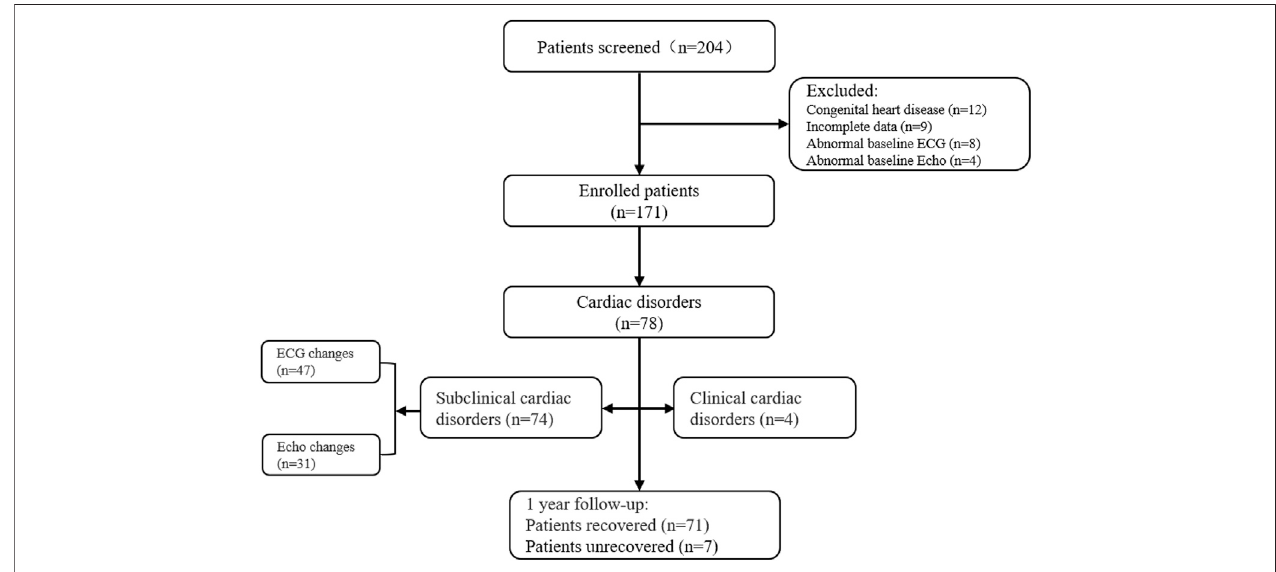
FIGURE 2 | Patients enrolment fl ow chart.